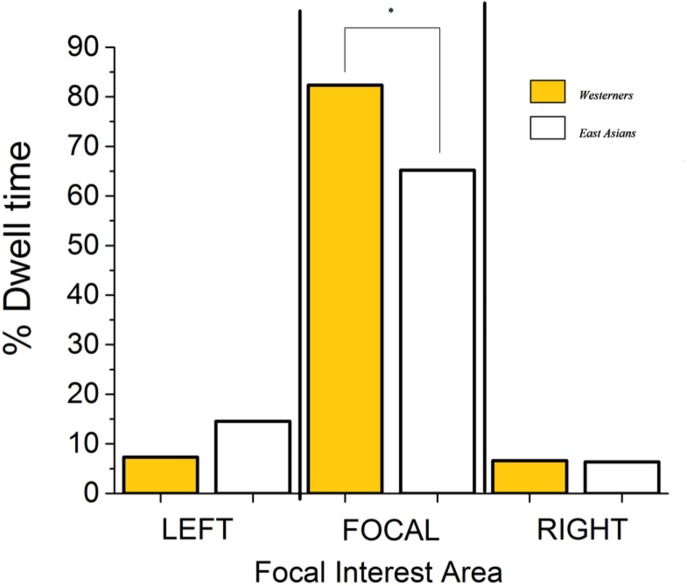
Percentage of eye dwell time in Areas of Interest. East Asians spent a significantly lower percent of eye dwell time than Westerners on the focal face. The asterisk denotes p < 0.01.